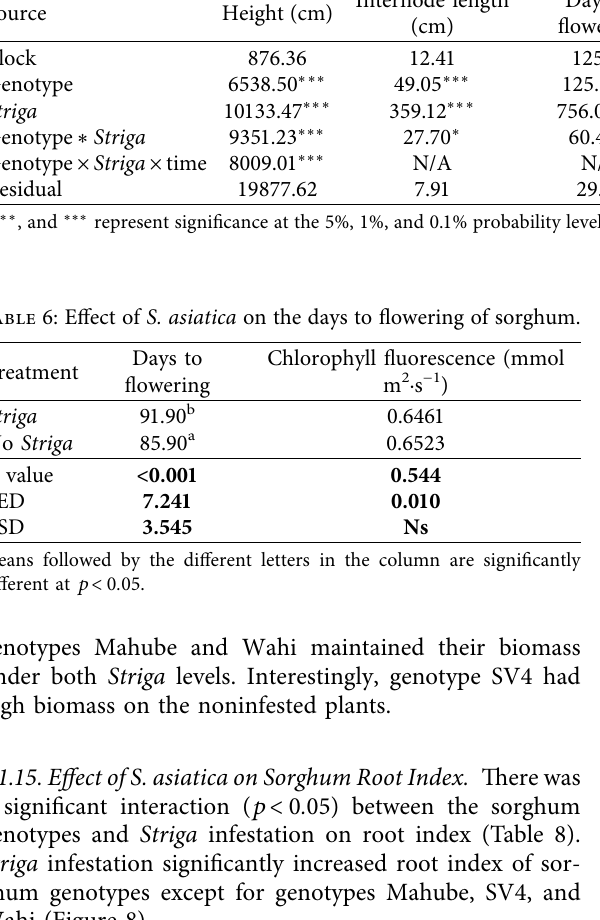
Genotype ∗ Striga